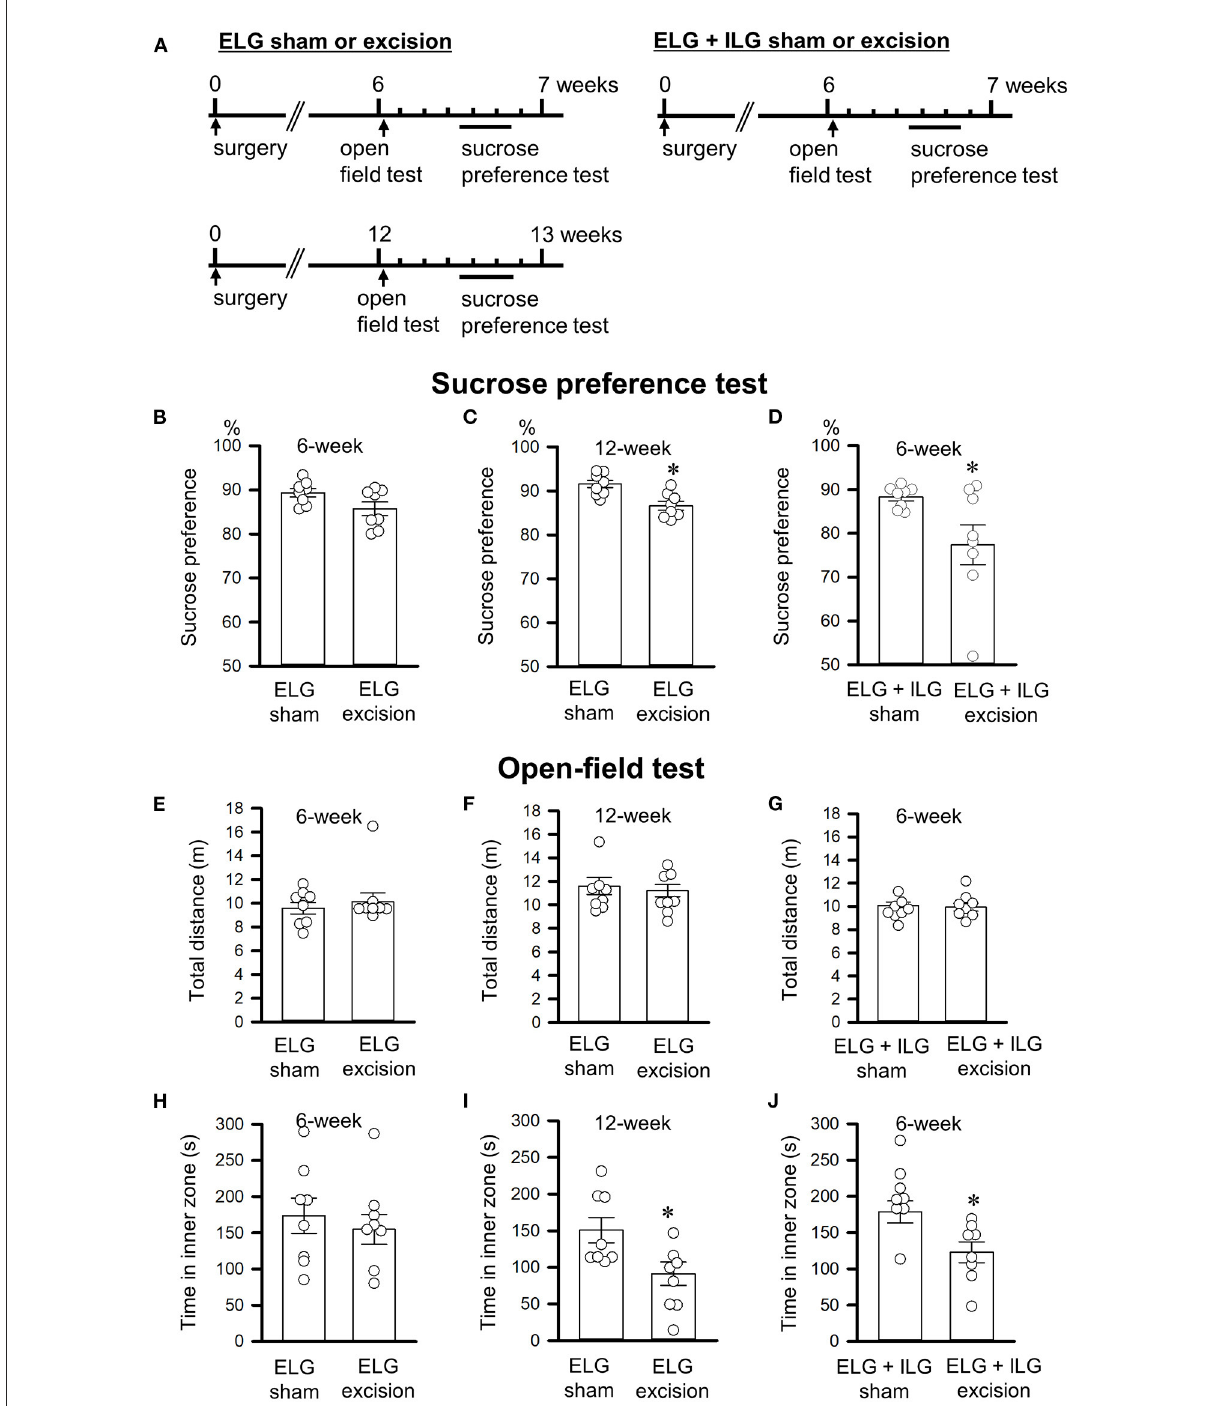
FIGURE3 Effects of lacrimal gland excision on behavioral performance in the sucrose preference and open-field tests. (A) Timelines of the experimental procedure. (B–D) Percentage sucrose intake relative to total intake in the sucrose preference test. (E–J) The total distance in the whole field (E–G) and the time spent in the inner zone (H–J) in the open-field test. (B,C,E,F,H,I) Tests were performed on ELG excision and sham-operated mice at 6 weeks (B,E,H) and 12 weeks after surgery (C,F,I) . (D,G,J) Tests were performed on ELG + ILG excision and sham-operated mice at 6 weeks after surgery. Each column and the corresponding vertical bar represent the mean ± SEM ( n = 8); open circles indicate individual values. * P < 0.05 vs . the sham-operated